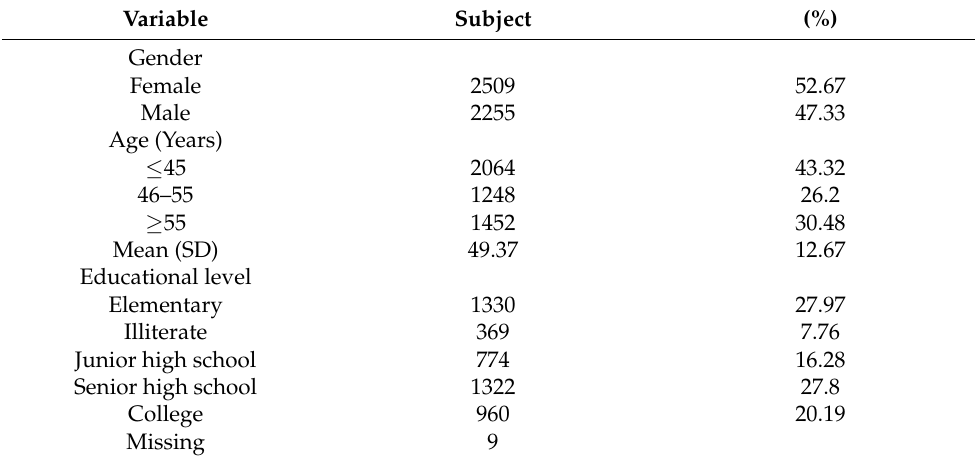
Table 1. Baseline characteristics of the study participants.